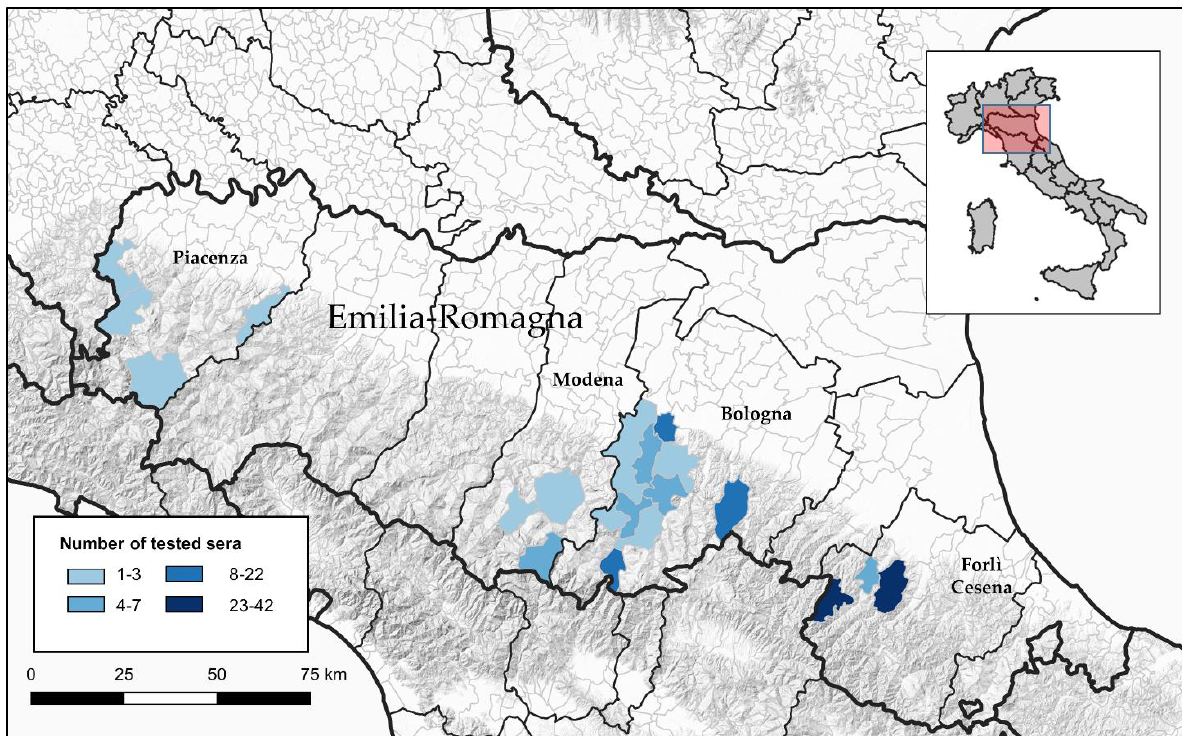
Figure 1. Map of municipalities of sample collection sites of tested animals.